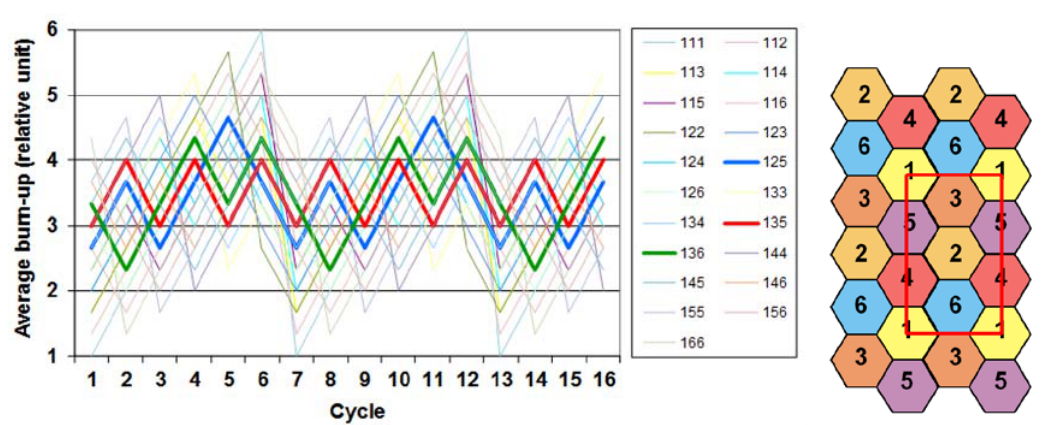
Figure 1. Average burn-up of three neighboring assemblies for all 21 possible combinations (left) and the radial layout of assembly reloading schemes for ESFR-SMART